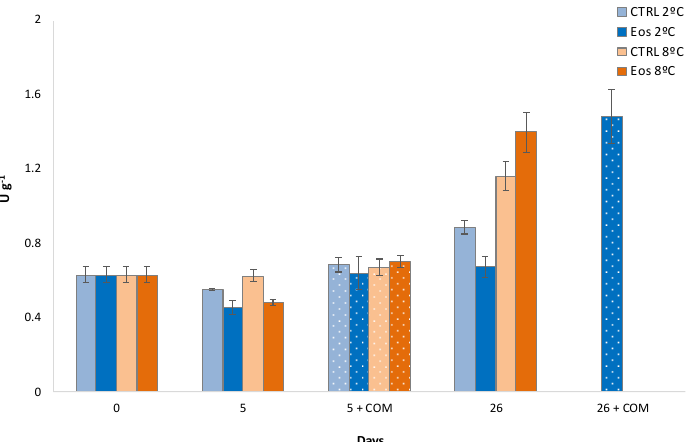
Figure 6. PPO activity during cold storage periods (2 and 8 °C) and complimentary commercialization simulations (COM; 4 days at 22 °C) for flat peaches with or without active paper sheets (including βCD-encapsulated EOs) ( n = 3 ± SD).